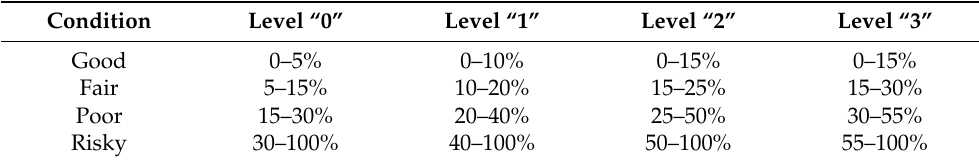
Table 3. The percentage thresholds of health index score for the condition assessment of devices of all criticality